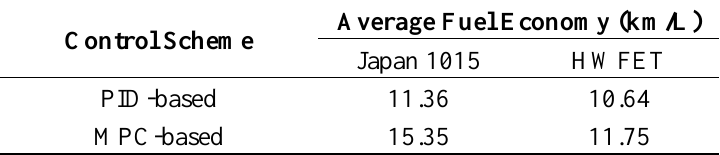
Table 4. Average fuel economy with different control